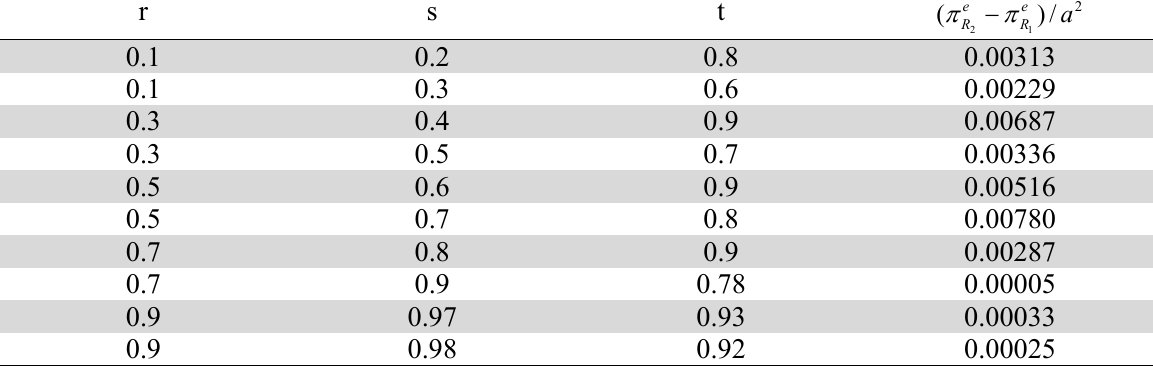
Numerical examples of (cid:4666)(cid:1870), (cid:1871), (cid:1872)(cid:4667) supporting Proposition 2